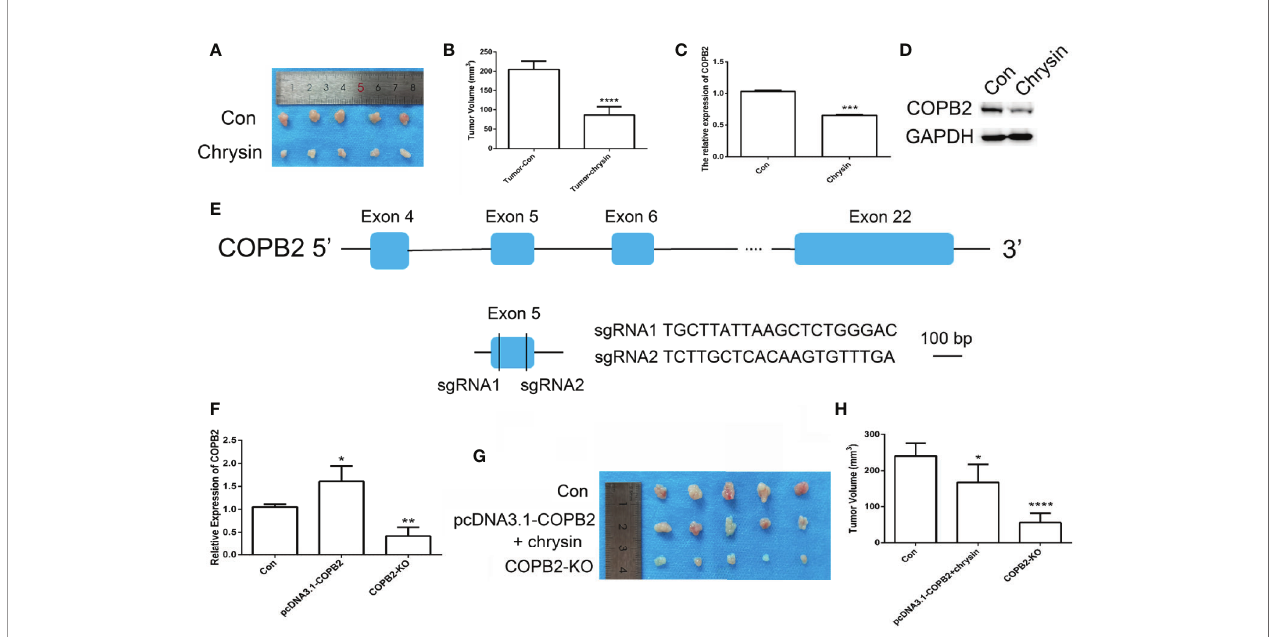
FIGURE 6 | CRISPR/Cas9-mediated gene targeting of COPB2 . Morphological observation of mouse tumor tissue (A) . Analysis of tumor volume (B) . The expression pattern of COPB2 in tumor of mice after chrysin treatment (C, D) . Schematic diagram of sgRNAs targeting the COPB2 gene loci (E) . The expression of COPB2 using qPCR (F) . The tumor morphology (G) and volume (H) . Blue indicated COPB2 . * ( p < 0.05), ** ( p < 0.01), *** ( p < 0.001) **** and ( p < 0.0001) indicate statistically signi fi cant